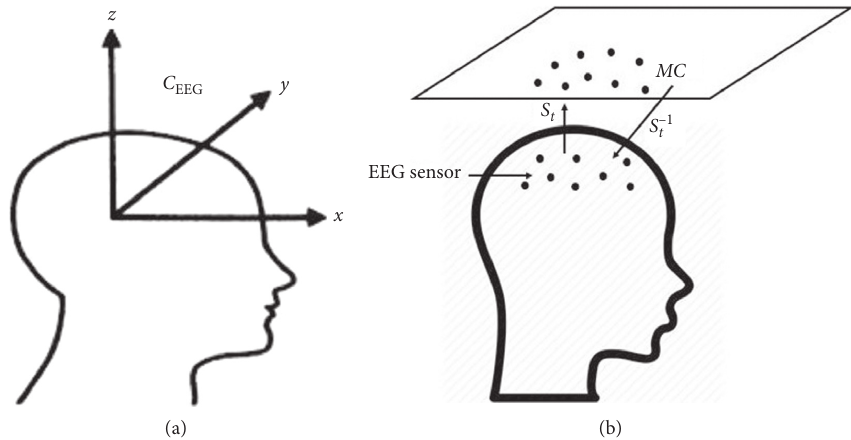
Figure 3: (a) EEG coordinate system and (b) EEG projection [70].